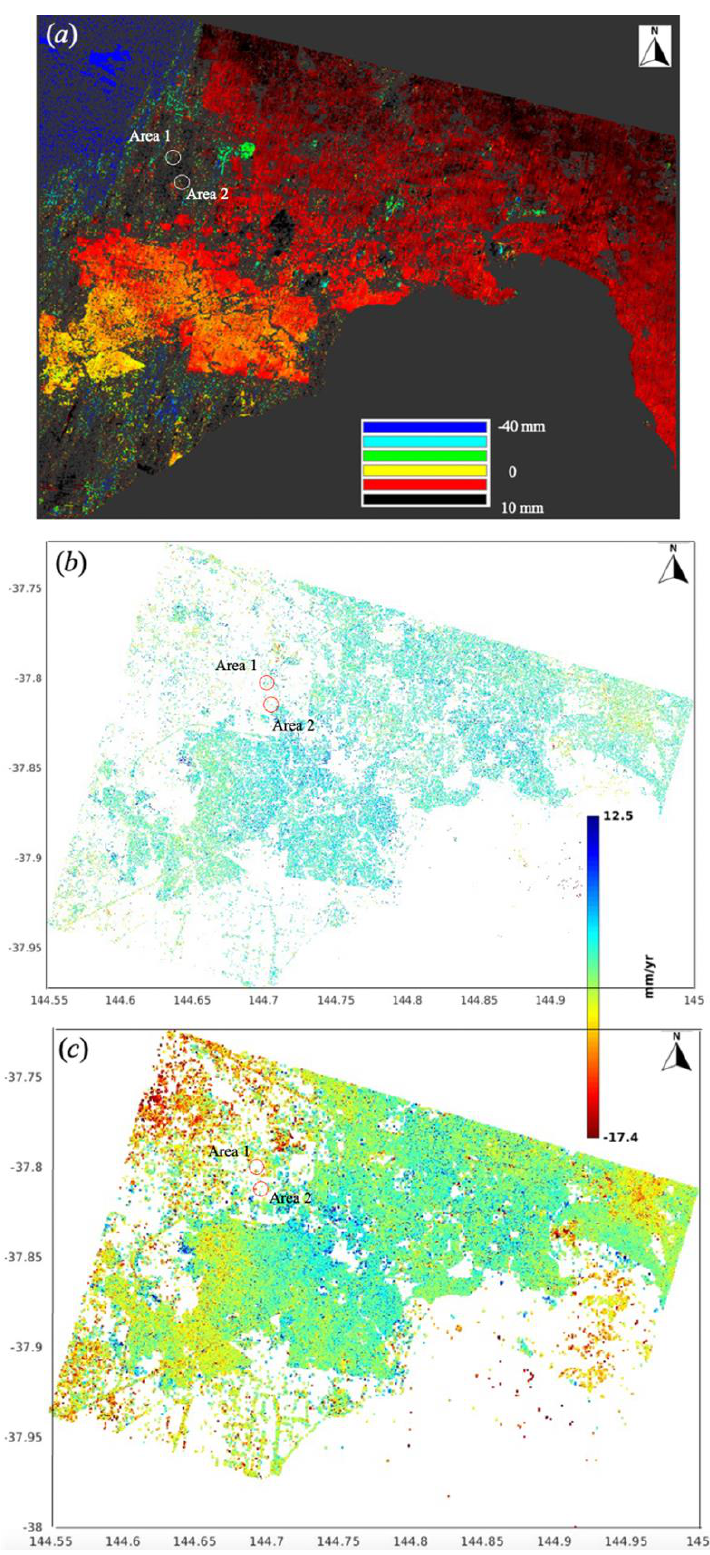
Figure 9. Estimates of ground displacement and velocity using ( a ) DInSAR, ( b ) PSI, and ( c ) SBAS.